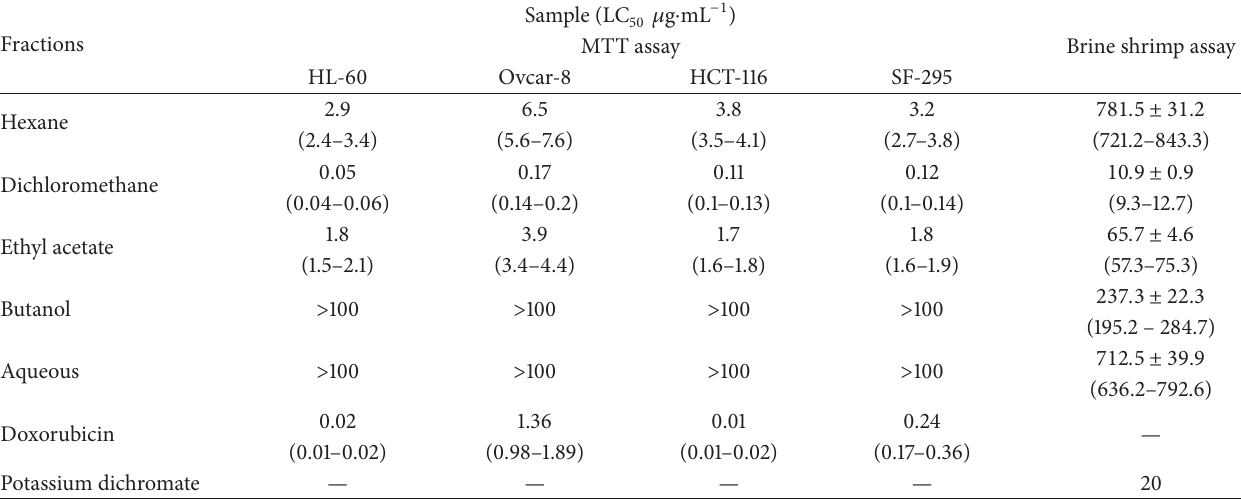
Table 2: Evaluation of toxicity potential of fractions of C. procera latex against cell lines and Brine shrimp nauplii.